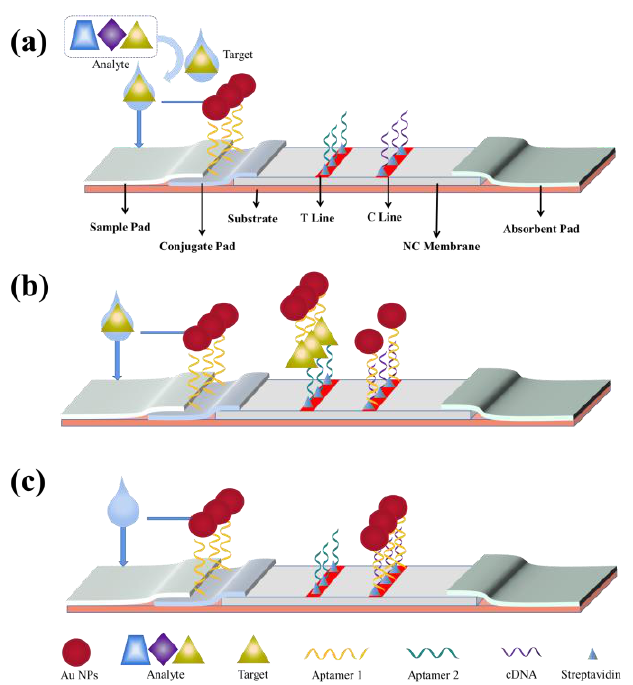
Figure 2. Schematic diagram for the operation principle of a typical sandwich-type test strip. ( a ) Sandwich-type lateral flow test strip diagram. ( b ) Reactions occurring in the sandwich-type lateral flow test strip in the presence of the target. ( c ) Reactions occurring in the sandwich-type lateral flow assay in the presence of no target. C line: control line; T line: test line.